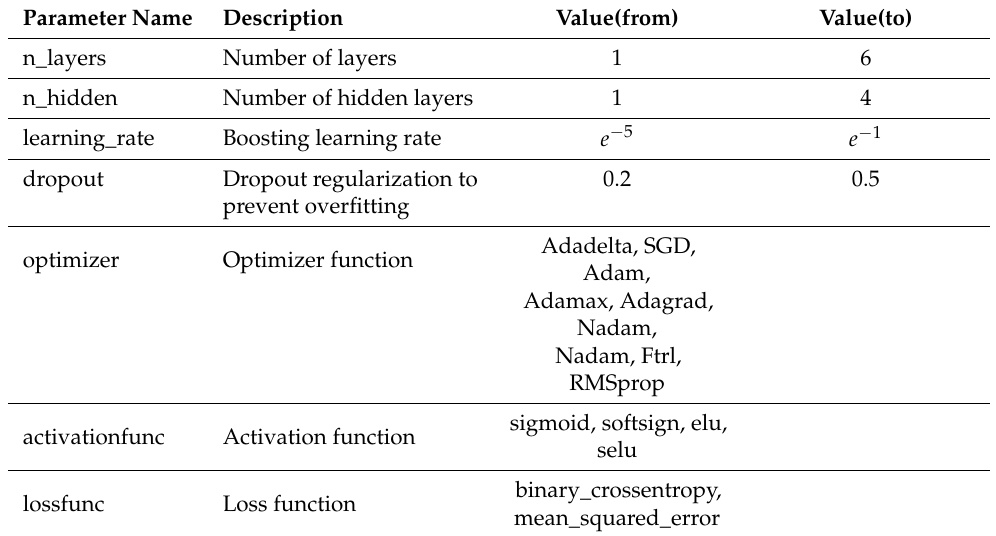
Table 4. DNN’s hyperparameter configuration thresholds.